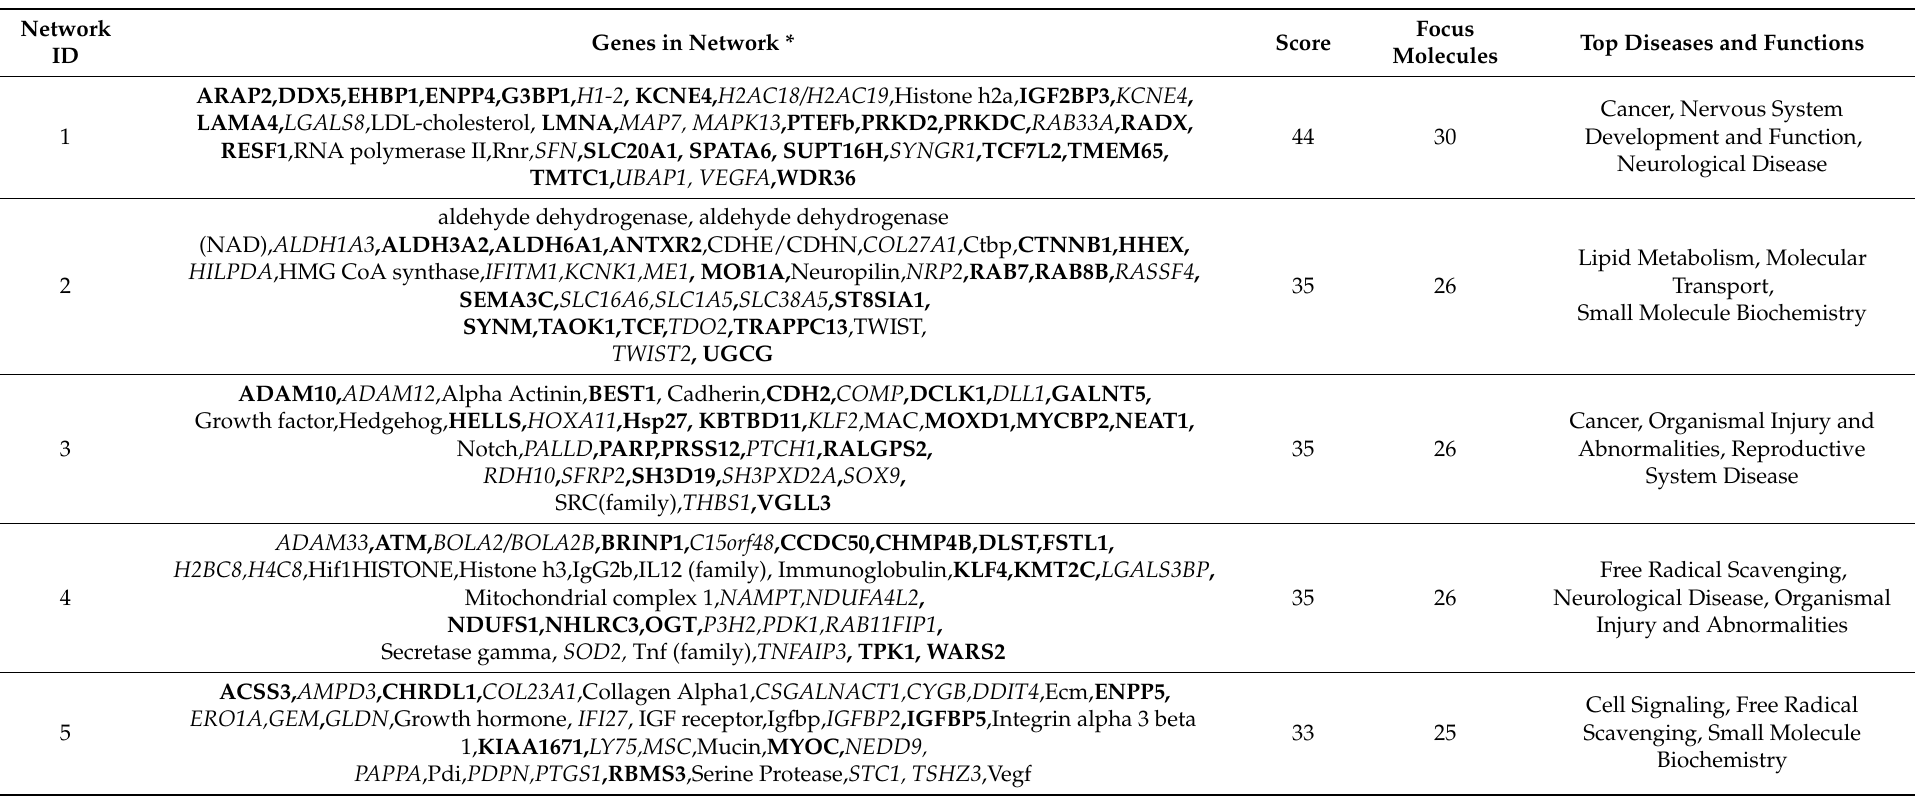
Table 7. Top five functional networks identified by IPA in skin fibroblasts and the associated differentially-regulated genes. See Supplementary Figures for depictions of additional IPA